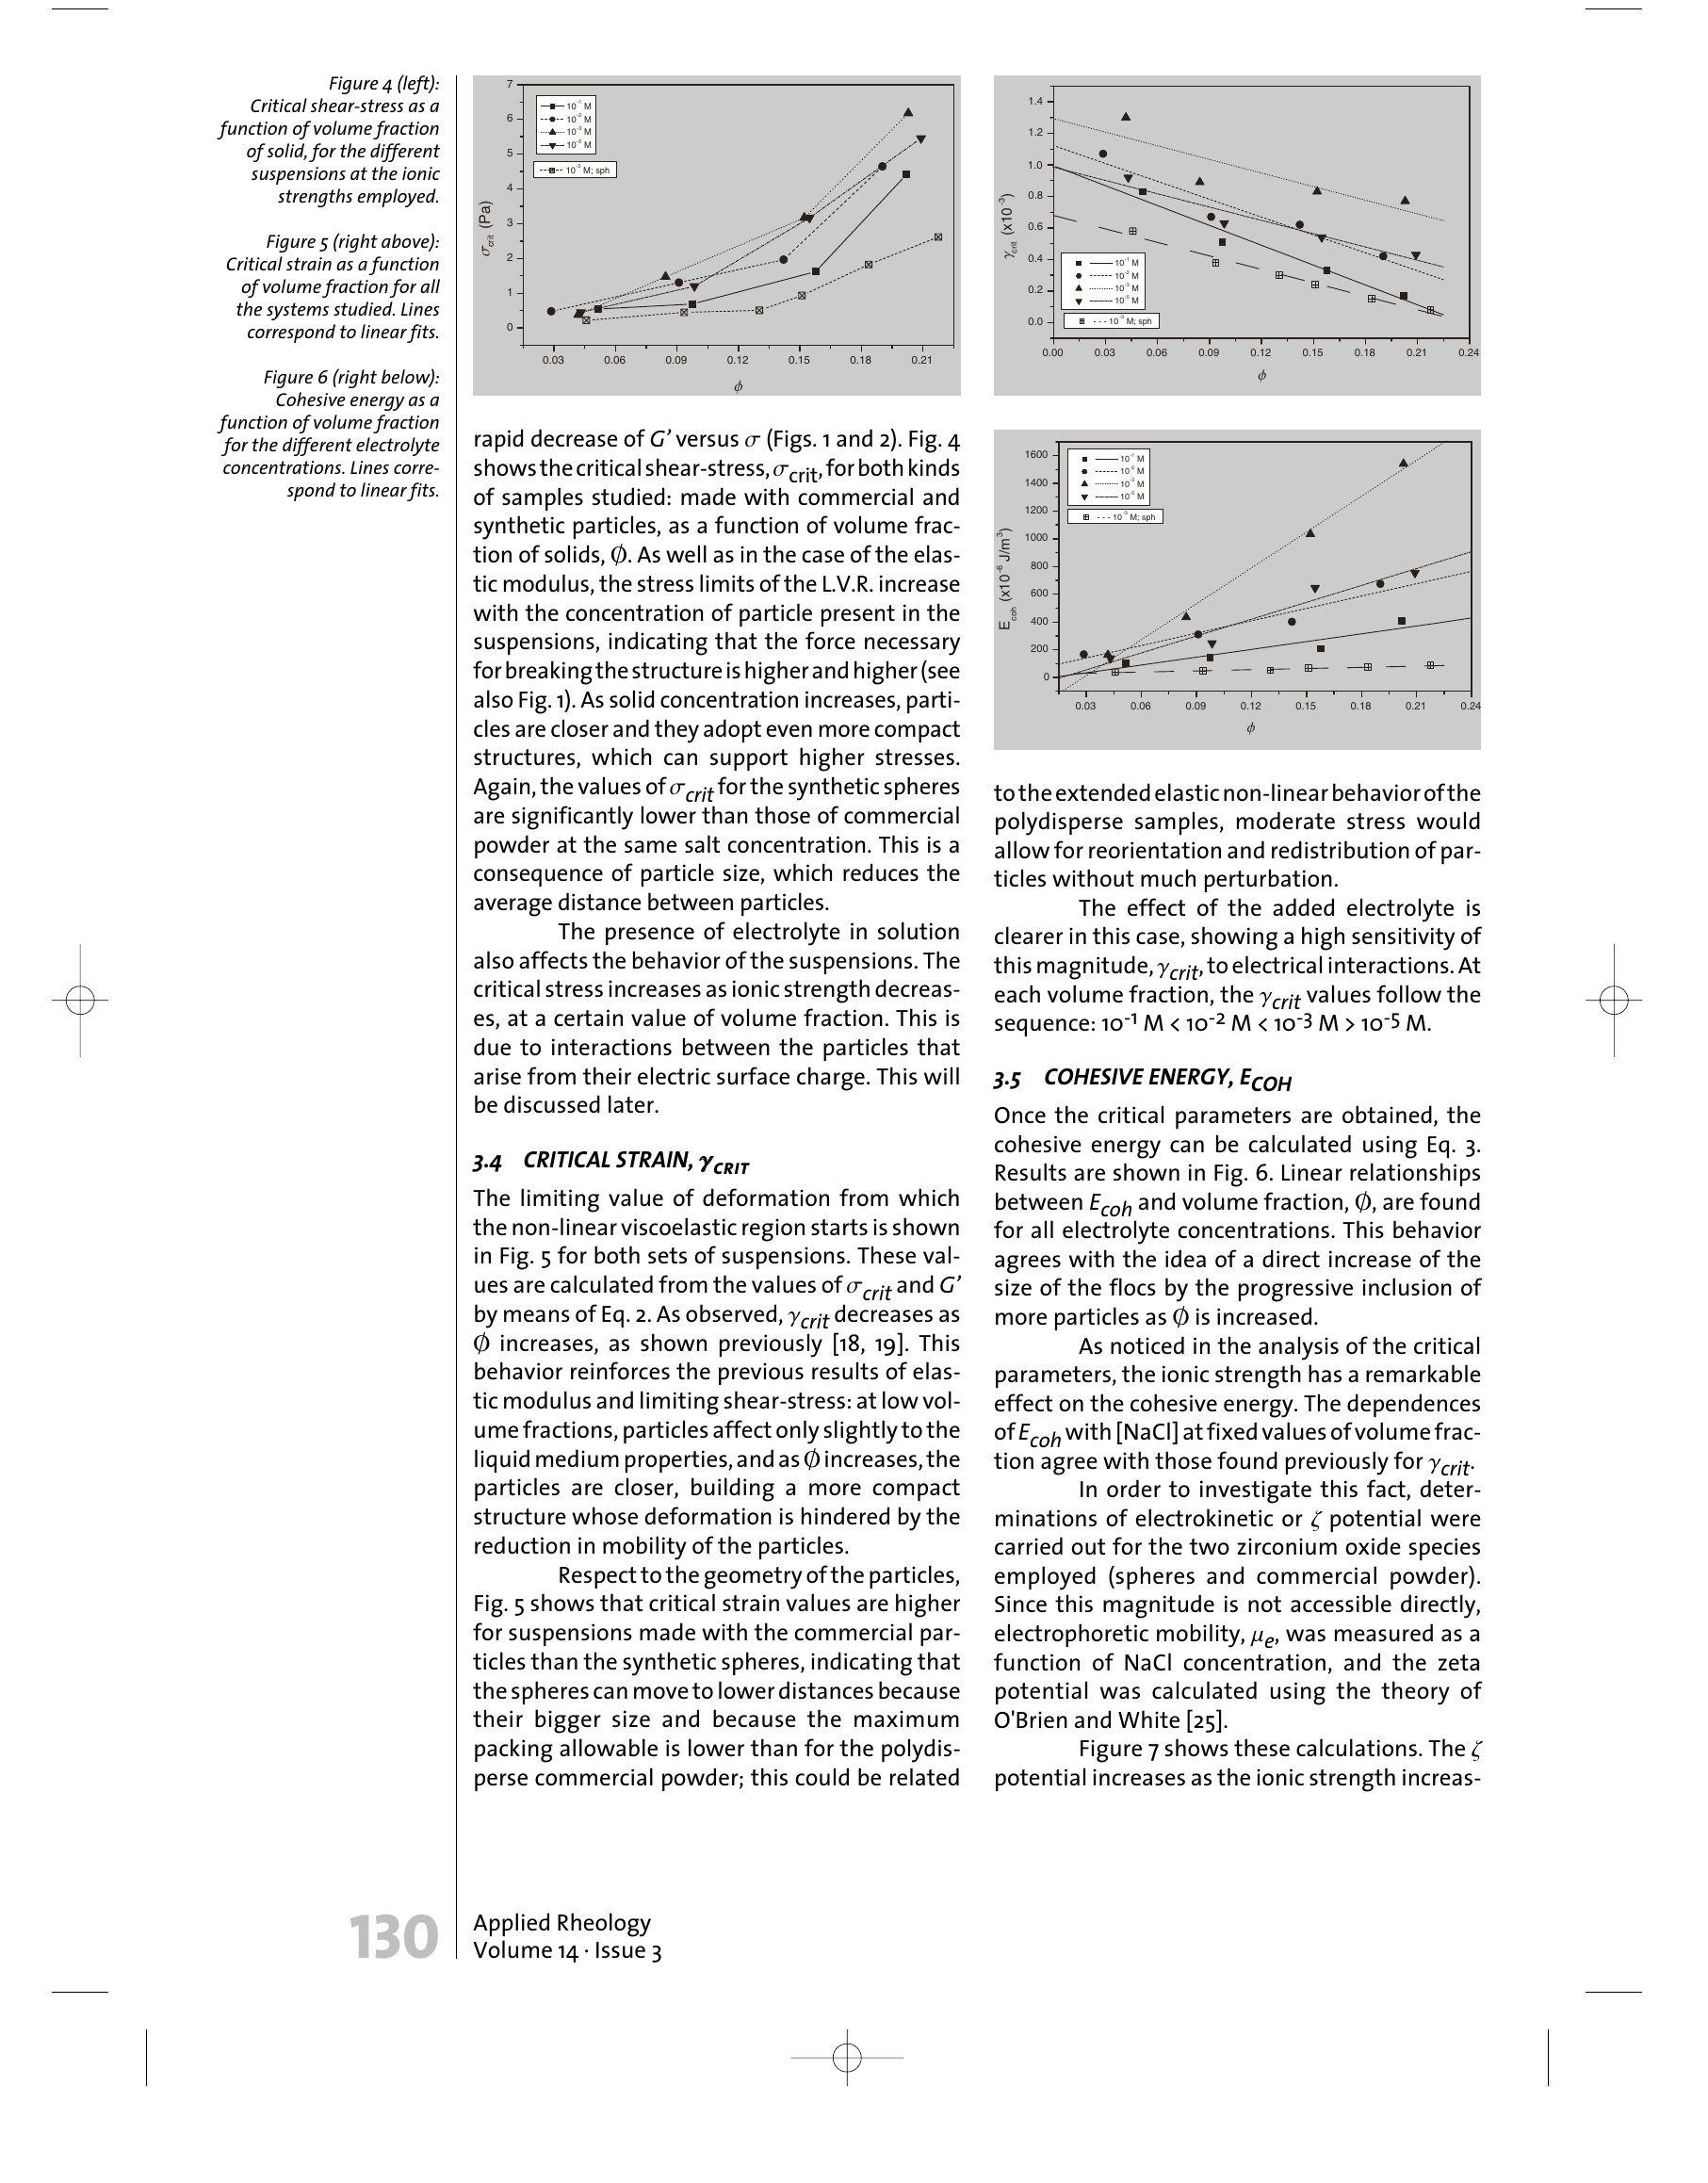
decrease of G’ versus s (Figs. 1 and 2). Fig. 4